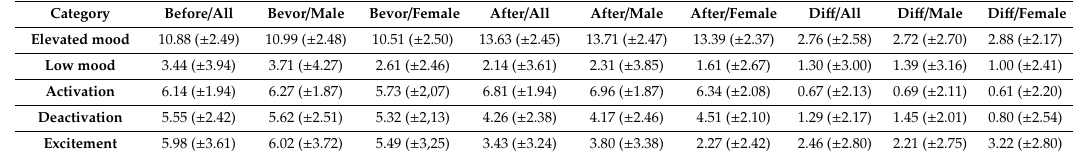
Table 3. Analytical statistics for the outcome variables; d = Cohen’s d and p = P -value. Cohen’s d and p -Values for the Di ff erences the Outcome Variables d / All d / Male d / Female p -Value / All Elevated